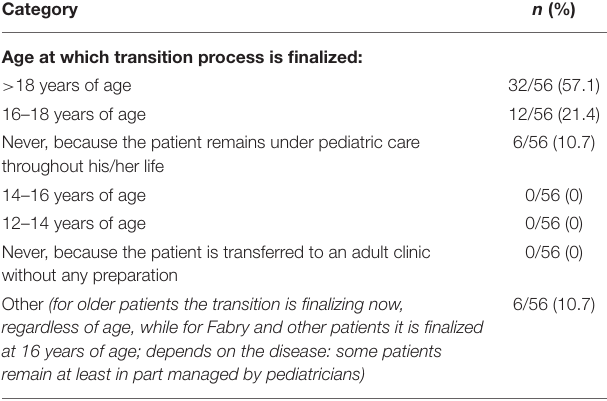
TABLE 1 | Characteristics of the responders and the relative